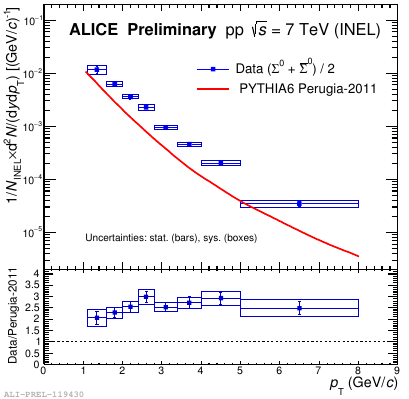
Figure 3. Transverse momentum spectrum of ( Σ 0 + Σ panel. Statistical (bars) and systematic (boxes) uncertainties are included. The solid line represents the spectrum from PYTHIA6 Perugia-2011 [3]. Ratio of ( Σ 0 + Σ in the corresponding p T bins is in the bottom